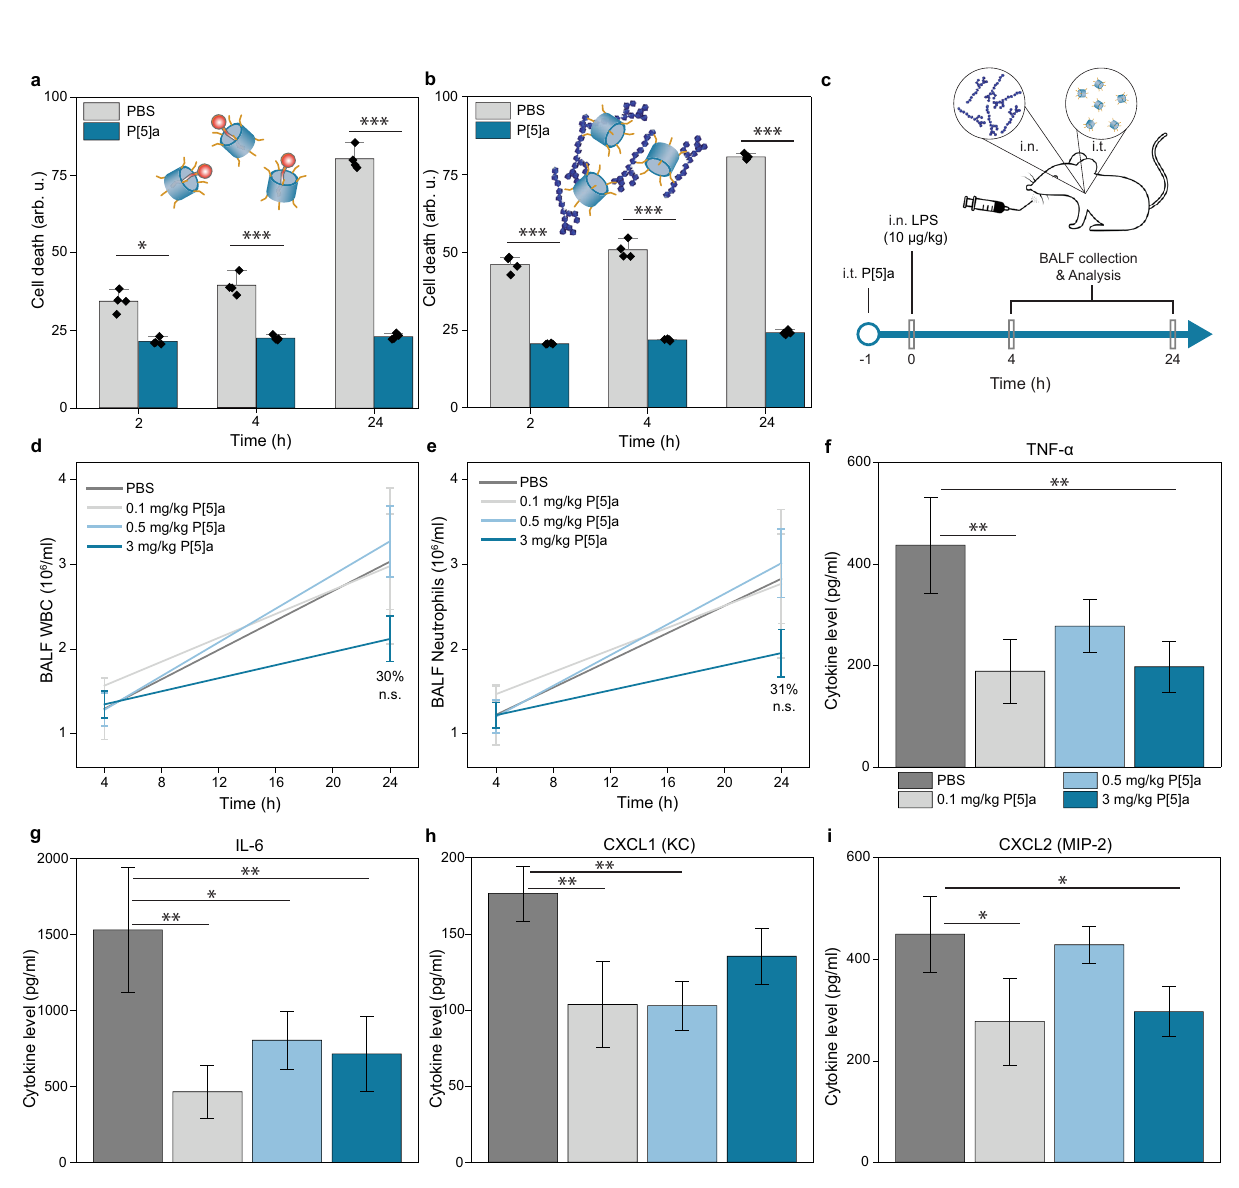
Fig. 7 | P[5]a sequesters toxins and protects against LPS endotoxin induced in fl ammatory responses in A549 epithelial cells and in C57BL/J6 mice. a The addition of P[5]a sequesters the 3-oxo-C12 HSL, protecting A549 epithelial cells against apoptosis over a 24h period. The data represent average values of biolo- gical replicates ± s.d ( n =4 per group). Two-tailed paired t-test *** P <0.001; ** P <0.01; * P <0.05. b The addition of P[5]a protects A549 epithelial cells against LPS-induced apoptosis over a 24h period( P.a . serotype 10, 20 µ g/ml). The data represent average valuesof biologicalreplicates ± s.d ( n =4 pergroup).Two-tailed pairedt-test*** P <0.001;** P <0.01;* P <0.05.c)LPSendotoxinsequestrationstudy design. P[5]a is administered intratracheally one hour prior to the addition of